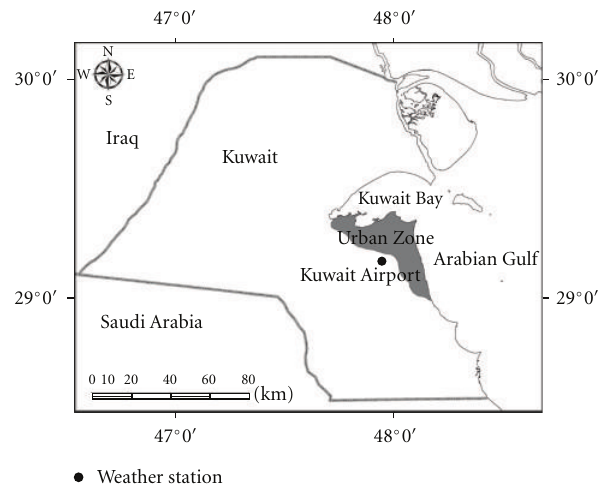
Figure 1: Location of the weather station in